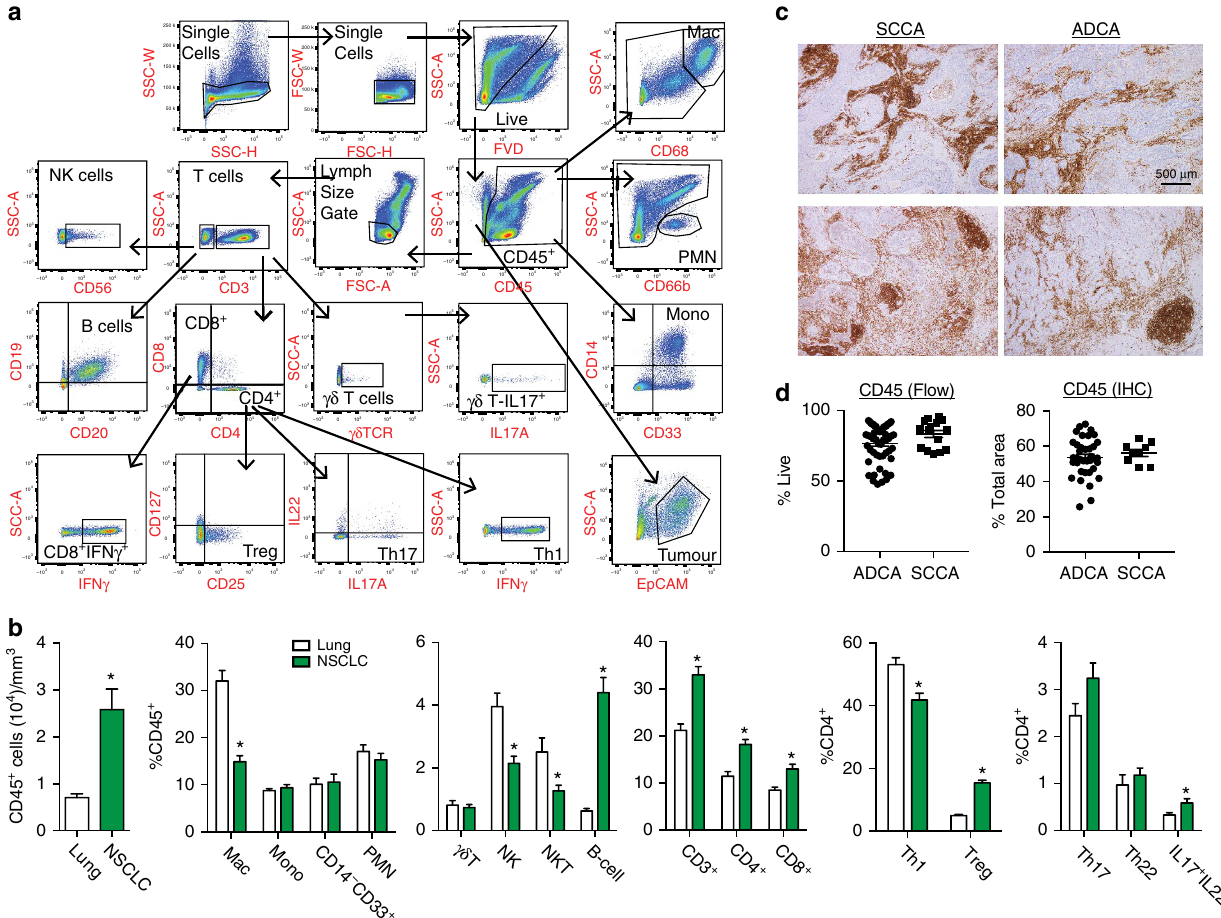
Figure 2 | Robust immune cell infiltration in NSCLC. ( a ) Representative polychromatic dot plots demonstrating the gating strategy employed to identify immune cell content in NSCLC. Starting at the top left, initial two gates are to eliminate doublets from the analysis followed by gating on live (FVD) and CD45 þ cells. For lymphocyte analysis, a size gate was applied followed by CD3 to identify: NK cells (CD3 (cid:3) CD56 þ ), B cells (CD3 (cid:3) CD19 þ CD20 þ ), gd T- cells (CD3 þ gd TCR þ ) and CD3 þ CD8 þ and CD3 þ CD4 þ T cells. T-cell subsets are displayed including CD8 þ INF g þ , Tregs (CD4 þ CD25 þ CD127 lo ), Th17 (CD4 þ IL17A þ ), Th22 (CD4 þ IL22 þ ), Th1 (CD4 þ INF g þ ) and gd TCR þ IL17A þ . Myeloid lineage cells were gated on CD45 þ cells: neutrophils (CD66b þ ), monocytes (CD14 þ CD33 þ ) and macrophages (CD68 hi ). Tumour cells were defined as CD45 (cid:3) EpCAM þ . ( b ) Tabulation of immune cell content from non-adjacent lung (white bars) and NSCLC (green bars) flow cytometry data. Data presented as CD45 þ cells per mm 3 , % CD45 þ , % CD4 þ , or % parent, as indicated. ( c ) Representative CD45 IHC depicting immune cell distribution in L-SCCA and L-ADCA specimens. Scale bar, 500 m m ( d ) Tabulation of CD45 content in L-ADCA and L-SCCA measured by flow cytometry ( N ¼ 73, left) and IHC ( N ¼ 46, right). Student’s tests were performed to compare two groups ( b , d ). Data are presented as mean ± s.e.m., * P o